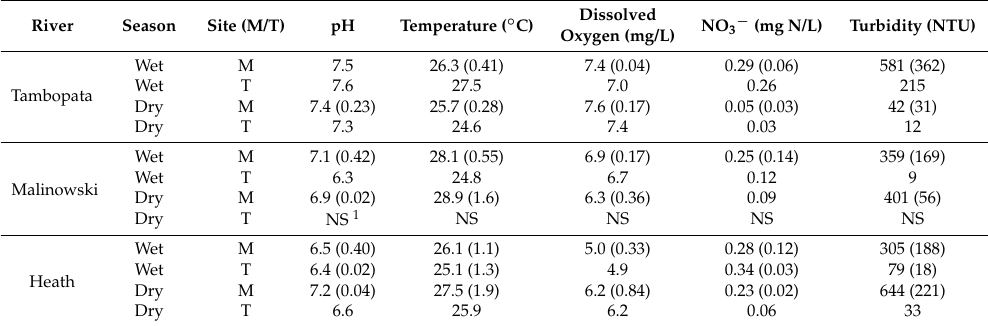
Table 1. Average physicochemical water quality parameters gathered from mainstem (M) and tributary (T) sites from each river for both wet and dry seasons. Values presented are means (± standard deviation).